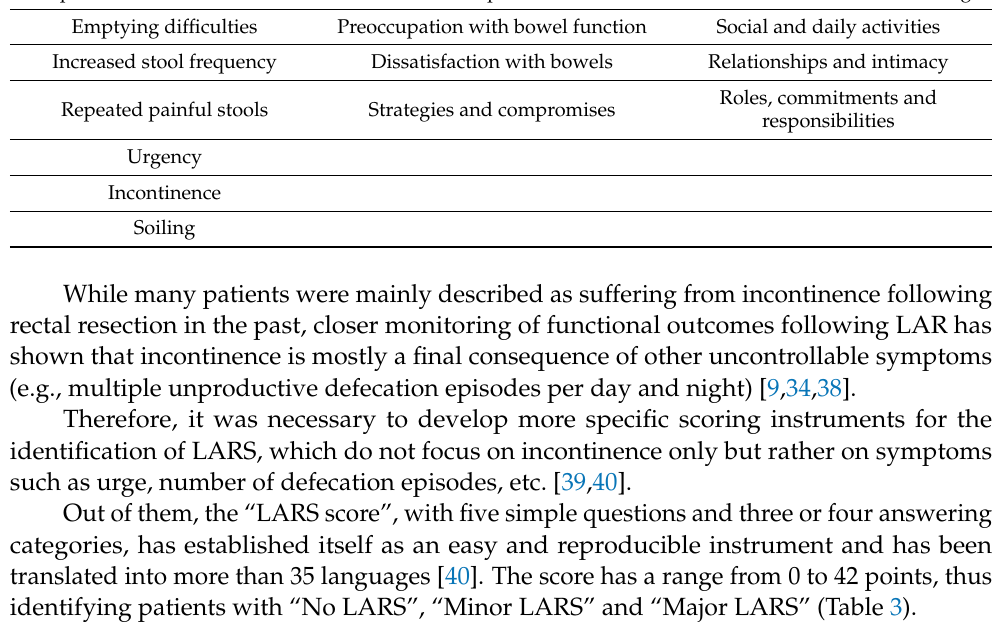
Table 3. Low Anterior Resection Syndrome Score—LARS Score